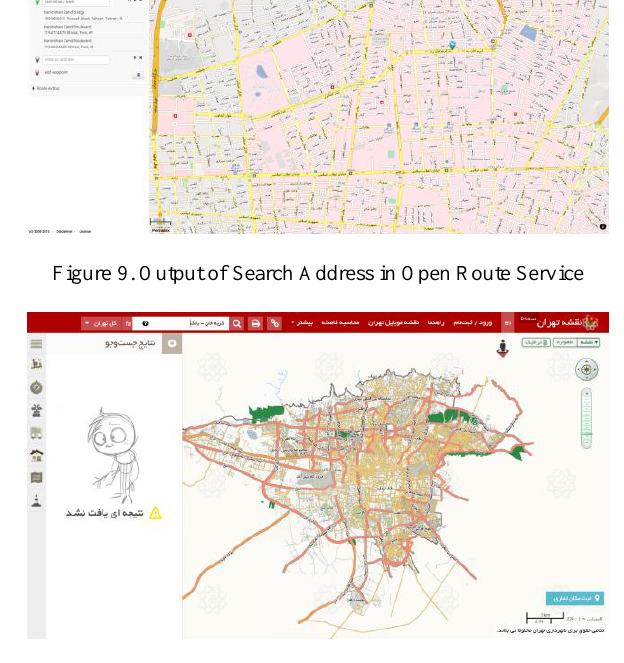
Figure 10. Output of search address in Tehran.ir